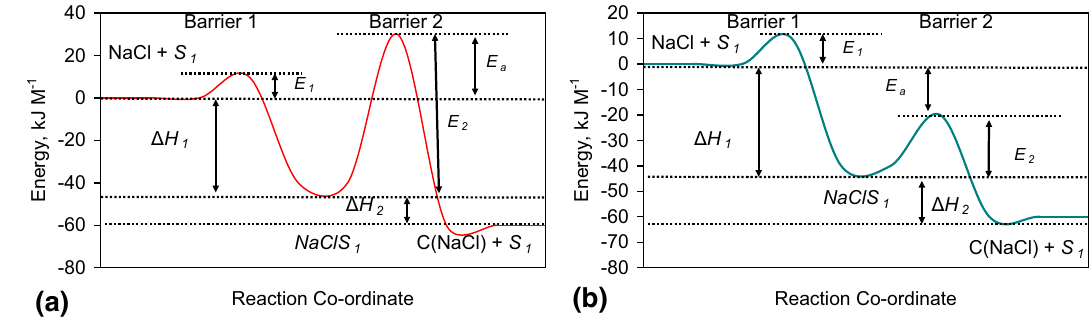
Fig. 2 Schematic energy versus reaction co-ordinate graphs illustrating the desalination process. a E